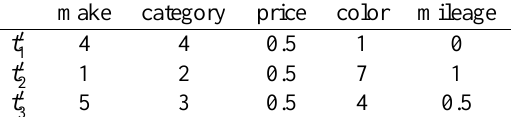
Table 4. Non-transitivity of